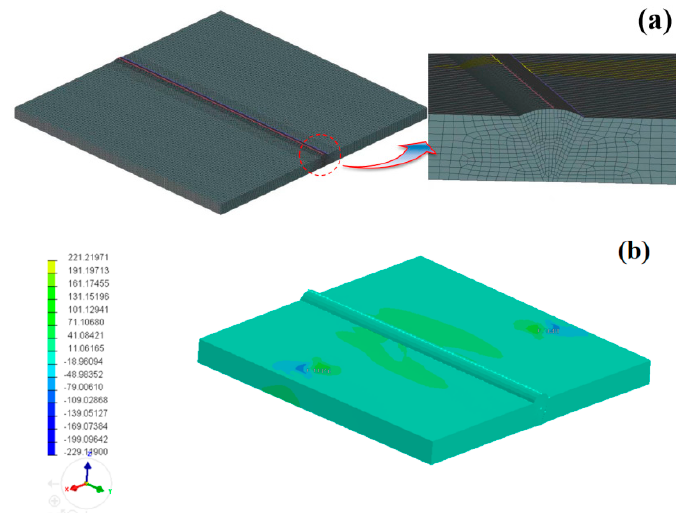
Figure 5. Finite element simulation of measured material. ( a ) Geometry for mesh definition. ( b ) Simulation result of longitudinal residual stress